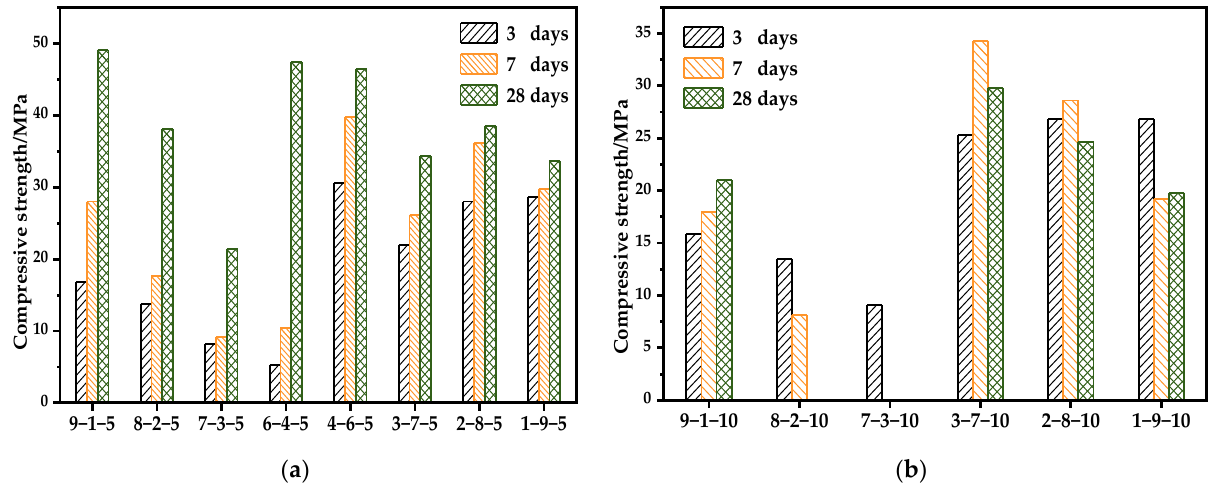
Figure 15. The compressive strength of OPC-CSA-CS ternary systems: ( a ) with 5% CS; ( b ) with 10% CS. Compared with the binary blends, the ternary blends show a similar strength varia- tion trend with the change in the OPC/CSA ratio. It can be seen from Figure 15a that the compressive strength of ternary blends decreases with the reduction in the OPC/CSA mass ratio in the OPC-dominated systems when the dosage of CS is 5%. Among them, however, the compressive strength of the 6-4 group grows suddenly compared to that of the 7-3 group at 7 d and 28 d. When CSA becomes the main component, the compressive strength at 3 d shows substantial improvement compared with the OPC-dominated ce- mentitious system, while the compressive strength at 28 d shows no significant growth in comparison with that at 3 d. Figure 15b shows that when the dosage of CS is 10%, other experimental groups demonstrate a strength loss, except for OPC/CSA = 9/1, which may be related to the time